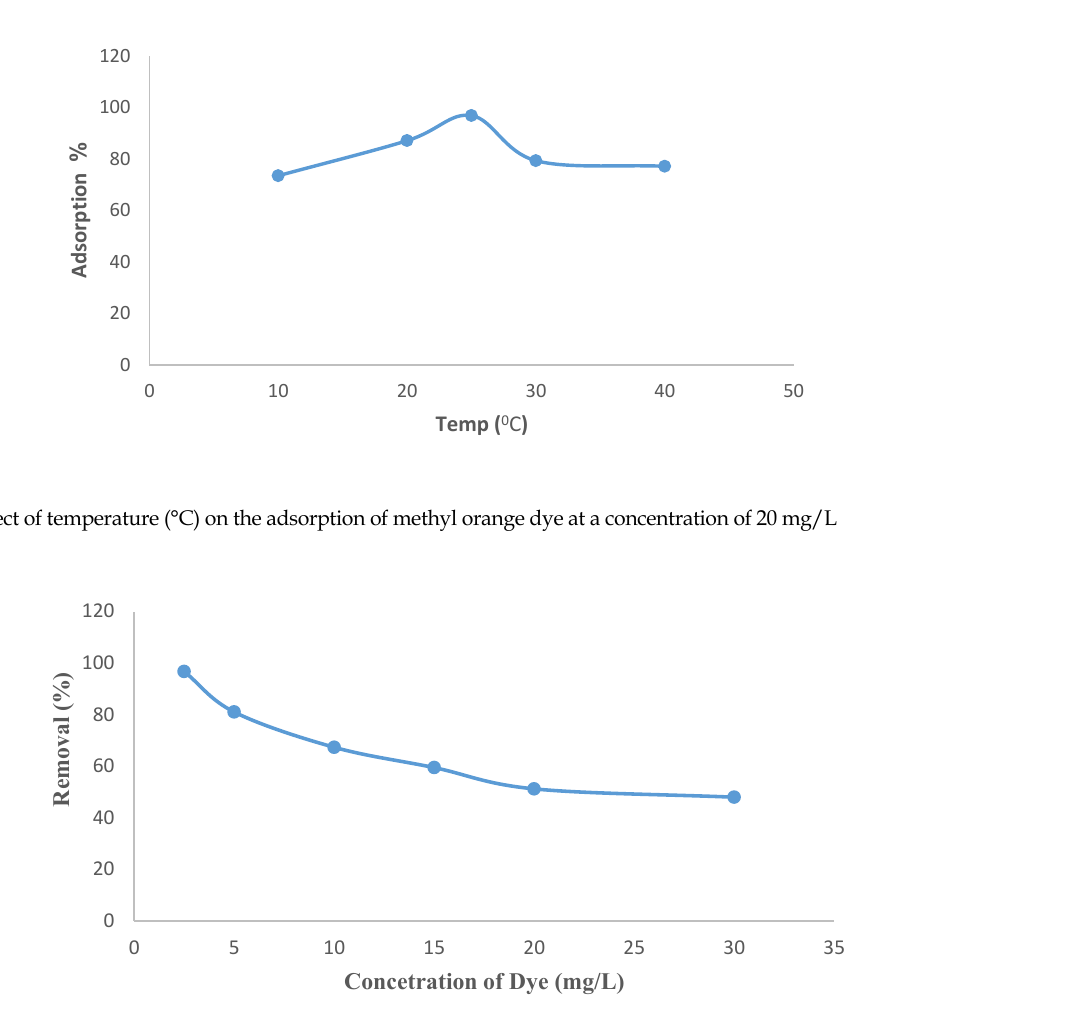
Figure 6. Effect of stirring speed (rpm) on the adsorption of methyl orange dye at a concentration of 20 mg/L